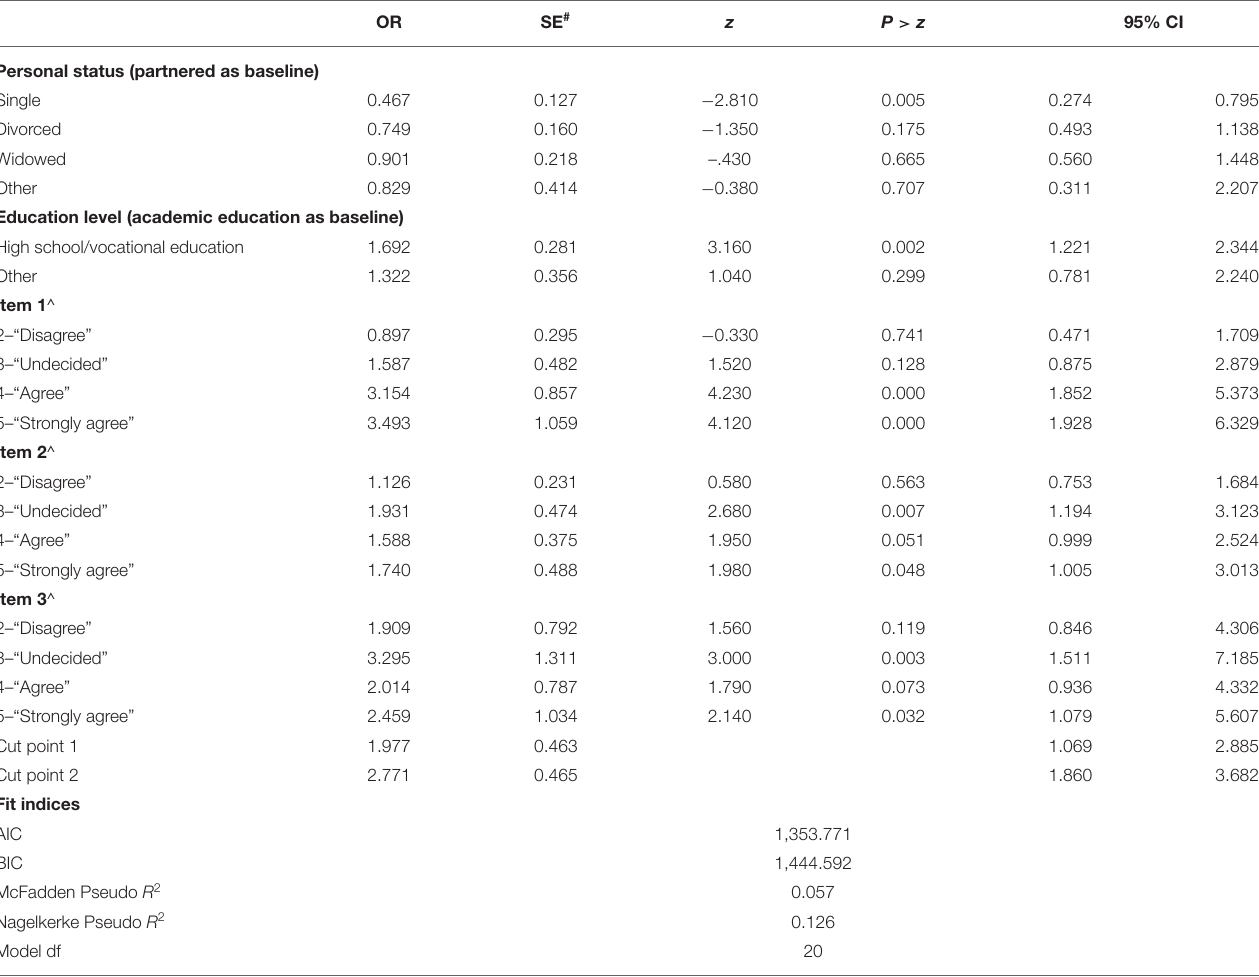
TABLE 5 | Results of OLR model predicting change of mind regarding telemedicine (0 = “Disagree,” 1 = “Neutral,” and 2 = “Agree”) ( N = 693). OR SE # z P > z 95%